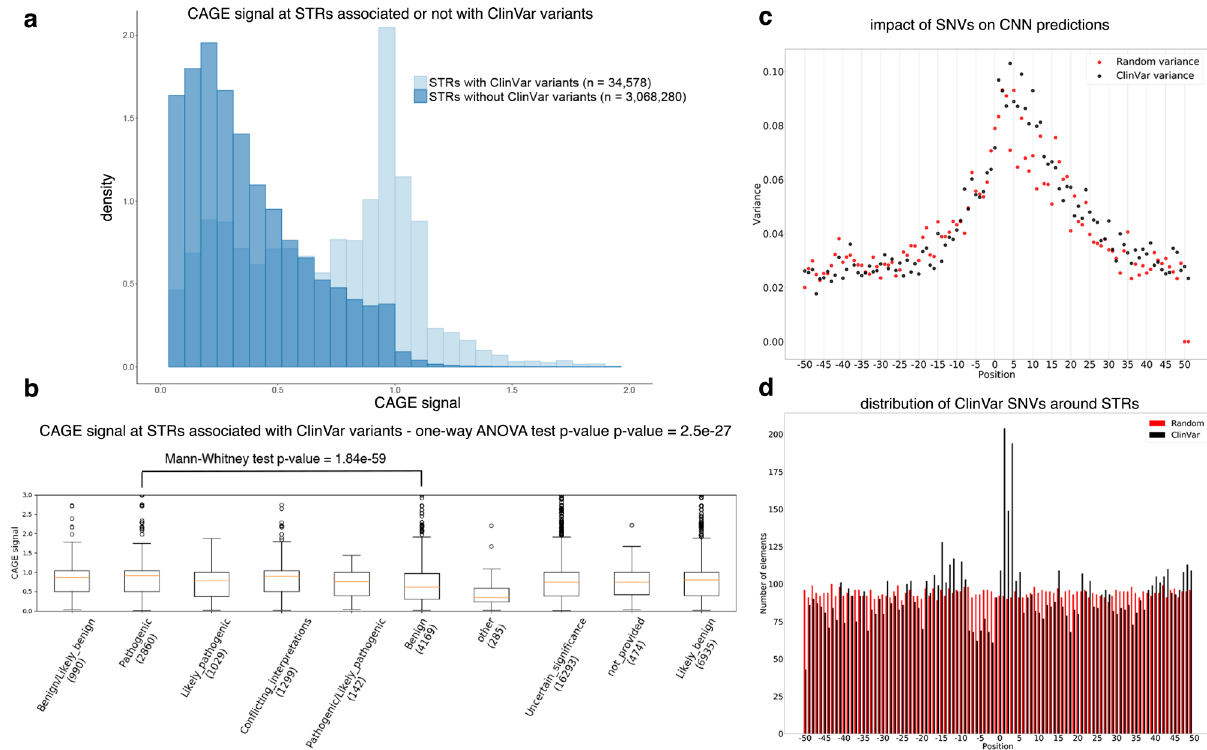
Fig. 7 ClinVar variants at STRs. a CAGE signal distribution of STRs associated (light blue) or not (dark blue) with at least one ClinVar variant. The number of STRs considered in each case is indicated in the bracket. b CAGE signal ( y axis) at STRs associated with ClinVar variants ordered according to their clinical signi fi cance ( x axis). The number of variants considered for each ClinVar class is indicated in the bracket. A one-way ANOVA test was used to assess overall statistical differences ( P value = 2.5e-27). Pairwise comparisons using one-sided Mann – Whitney rank tests were also performed ( P values are indicated in Supplementary Fig. 12). Boxplots are de fi ned as in Fig. 1d. c Impact of the changes induced by ClinVar (black) and random (red) variants on CNN predictions. Predictions are made on the hg19 reference sequence and on a mutated sequence, containing the genetic variants. Changes are then computed as the difference between these two predictions (reference - mutated, Supplementary Fig. 13) and their impact is measured as their variance at each position around STR 3' end ( x axis). To keep sequences aligned, only single nucleotide variants (SNVs) were considered. d Distribution of ClinVar (black) and random (red) variants around STR 3' end. The number of variants and their position relative to STR 3' end (position 0) are indicated on the y axis and x axis, respectively. A Kolmogorov – Smirnov test was used to assess statistical signi fi cance between the distribution of ClinVar variants and that of random variations ( P value =